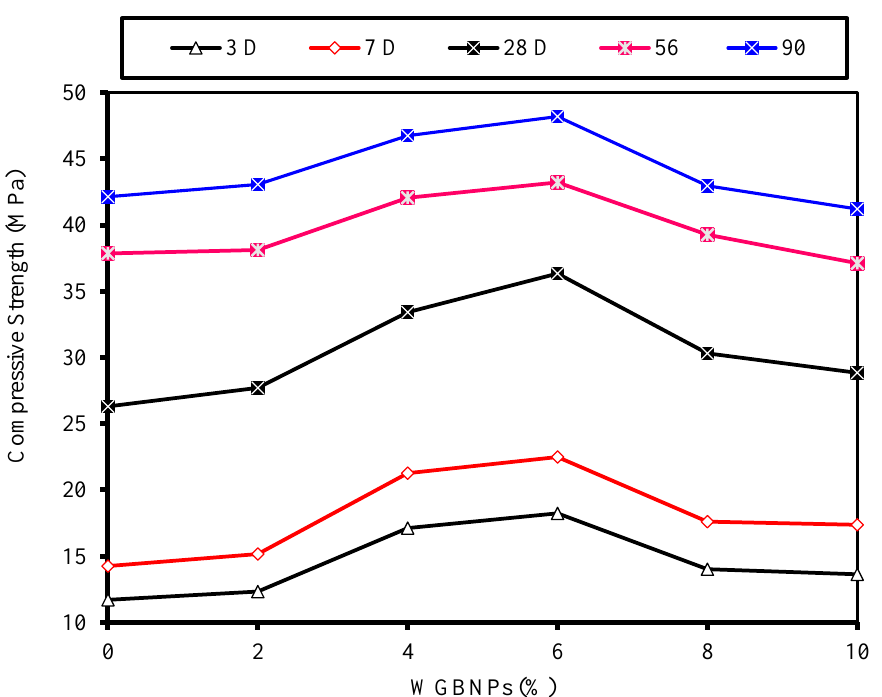
Figure 8. Influence of WGBNPs on strength, where 0% refers to the strength of the EM specimen.